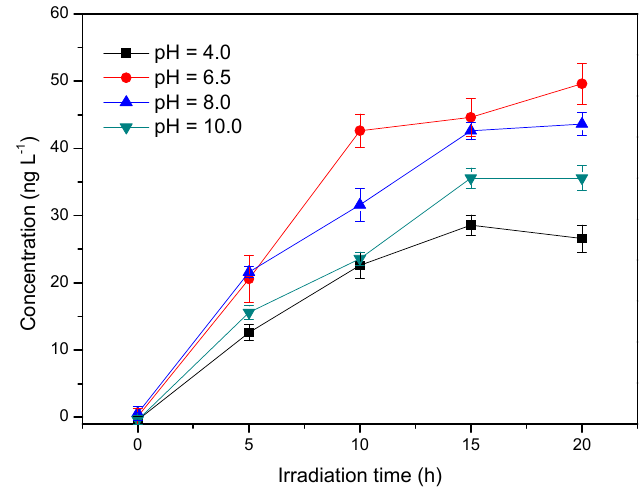
Figure 5. Effect of pH on the production of methyl chloride. Reaction conditions: light intensity = 12 mW cm − 2 . [Cl − ] = 0.5 mol L − 1 , [HA] = 5 mg L − 1 .